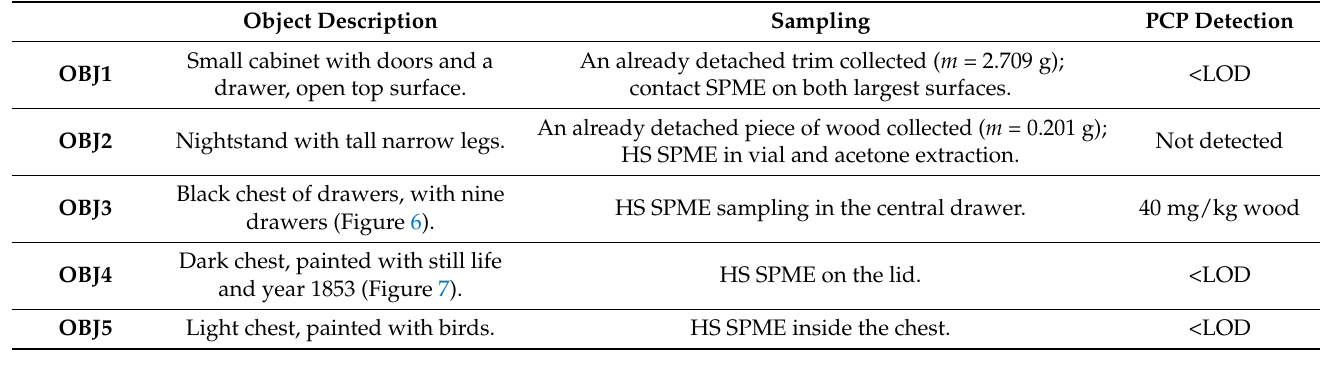
Table 2. Description of the museum objects examined, sampling methods used and the PCP detection.